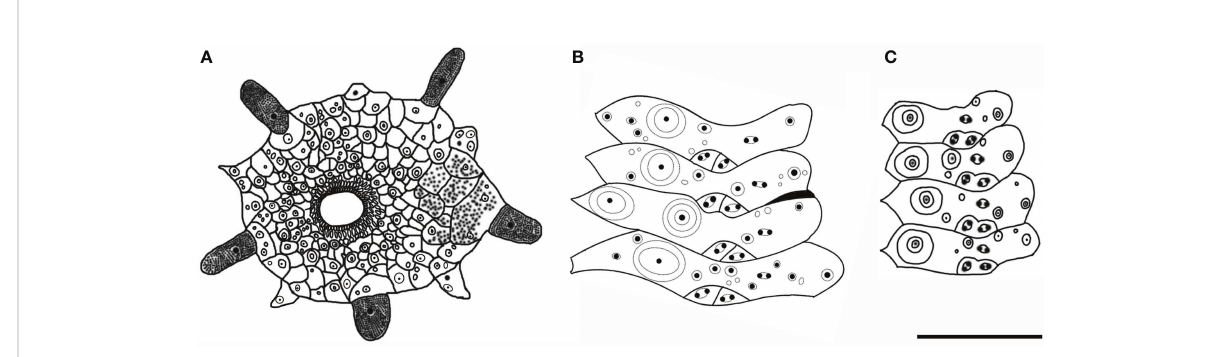
FIGURE 3 Hygrosoma involucrum sp. nov. (A) Paratype, MBM286940. Apical system. (B, C) Ambulacral plates from the aboral side: (B) from the paratype, MBM286970 (C) . from the holotype, MBM286941. Scale bar , 10 mm.